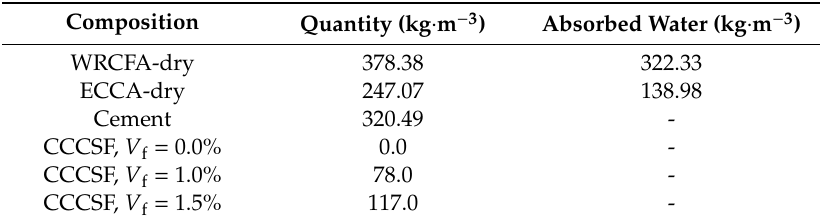
Figure 1. Waste red ceramic fine aggregate ( a ); expanded clay coarse aggregate ( b ); copper coated crimped steel fibre ( c ). Table 1. Mixture proportions of a cubic meter of mixture